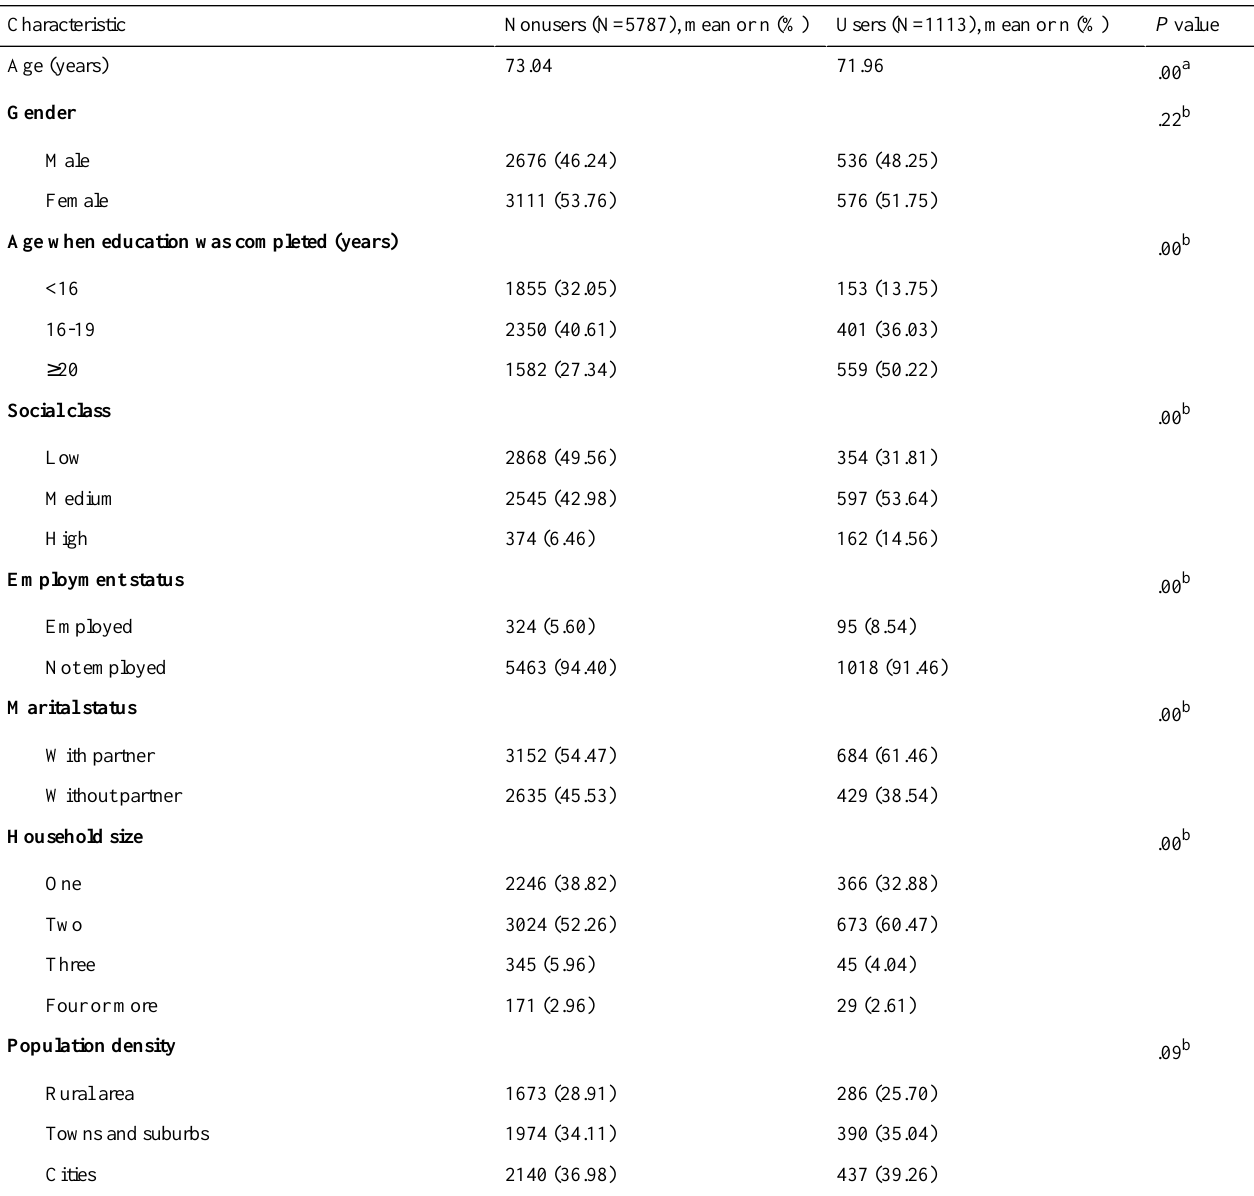
Table 2. Characteristics of the users and nonusers of internet-based health care